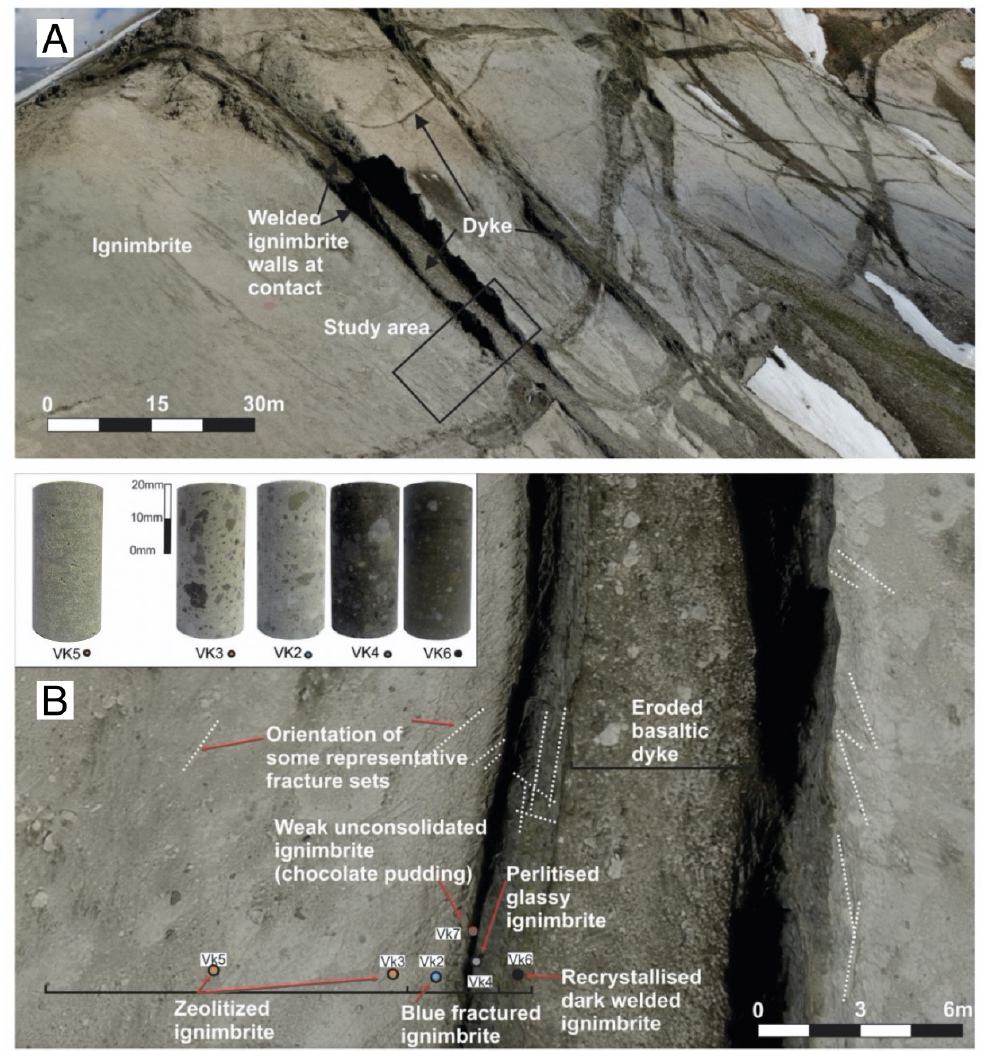
Figure 2: [A] Structure from motion photogrammetry reconstruction (orthophoto) of an oblique view (from the East) of the field site at Hvítserkur (East Iceland). [B] Study area with sample and scan line locations marked. Orientations of some fractures are highlighted by dotted white lines. Photographs of examples of the 20 mm- diameter cylindrical samples prepared for the laboratory measurements (inset): VK5 and VK3 zeolitized ignimbrite samples, VK2 blue ignimbrite, VK4 perlitised ignimbrite, and VK6 dark